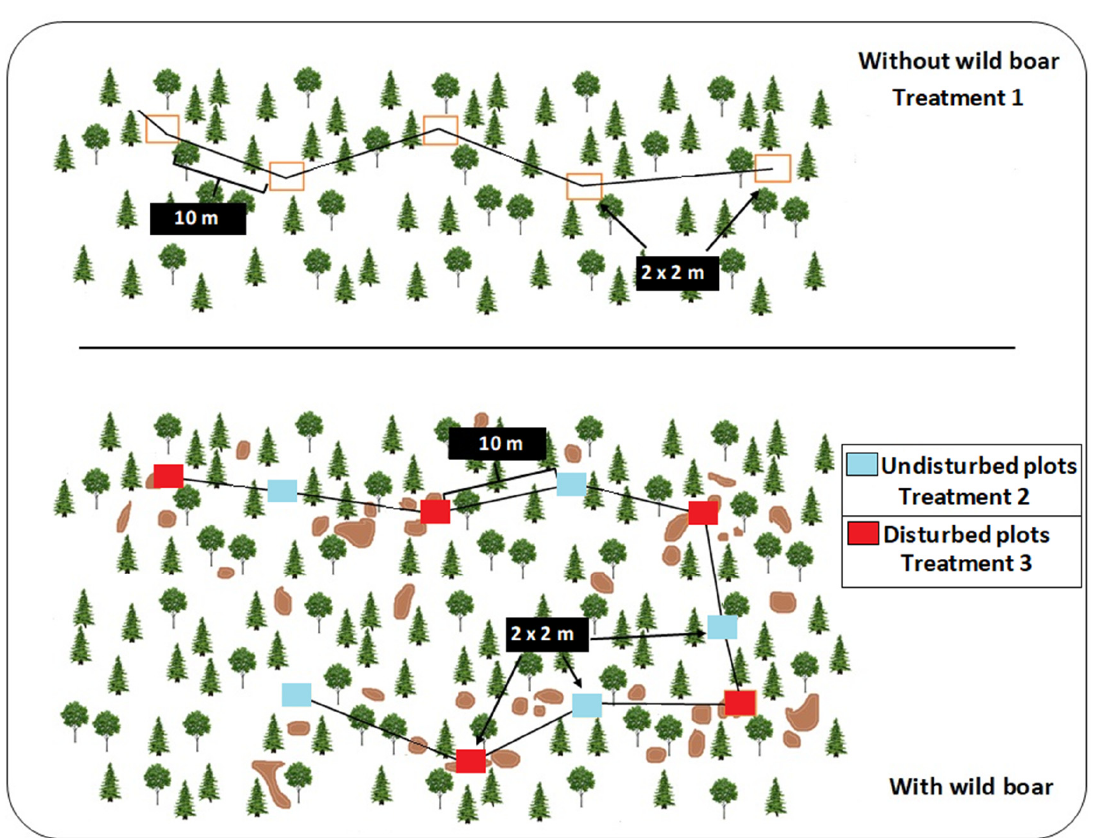
Figure 2 . Depiction of the distribution of plots for wild boar ( below ) and without wild boar sites ( above ), used in the wild boar–fungal interactions in Gävleborg, Uppsala and Västmanland, central Sweden.